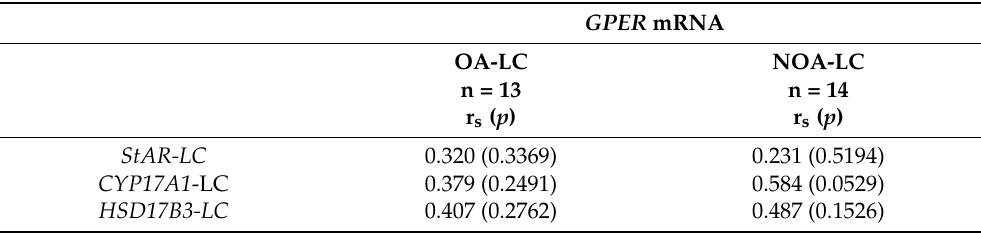
Figure 6. Transcriptional levels of: ( a ) steroidogenic acute regulatory protein (StAR); ( b ) 17 α -hydroxylase/17,20-lyase (CYP17A1); ( c ) 17 β -hydroxysteroid dehydrogenase 3 (HSD17B3) in the laser-microdissected Leydig cell clusters in the analyzed subgroups (OA-LC and NOA-LC). AU—arbitrary units (relative quantification normalized to the reference gene RPS29 using the ∆ Ct method). Data are presented as mean ± EM; p value—Mann–Whitney test. Table 11. Spearman’s rank (r s ) correlation between the GPER and Leydig cell markers mRNA expression levels in OA-LC and NOA-LC